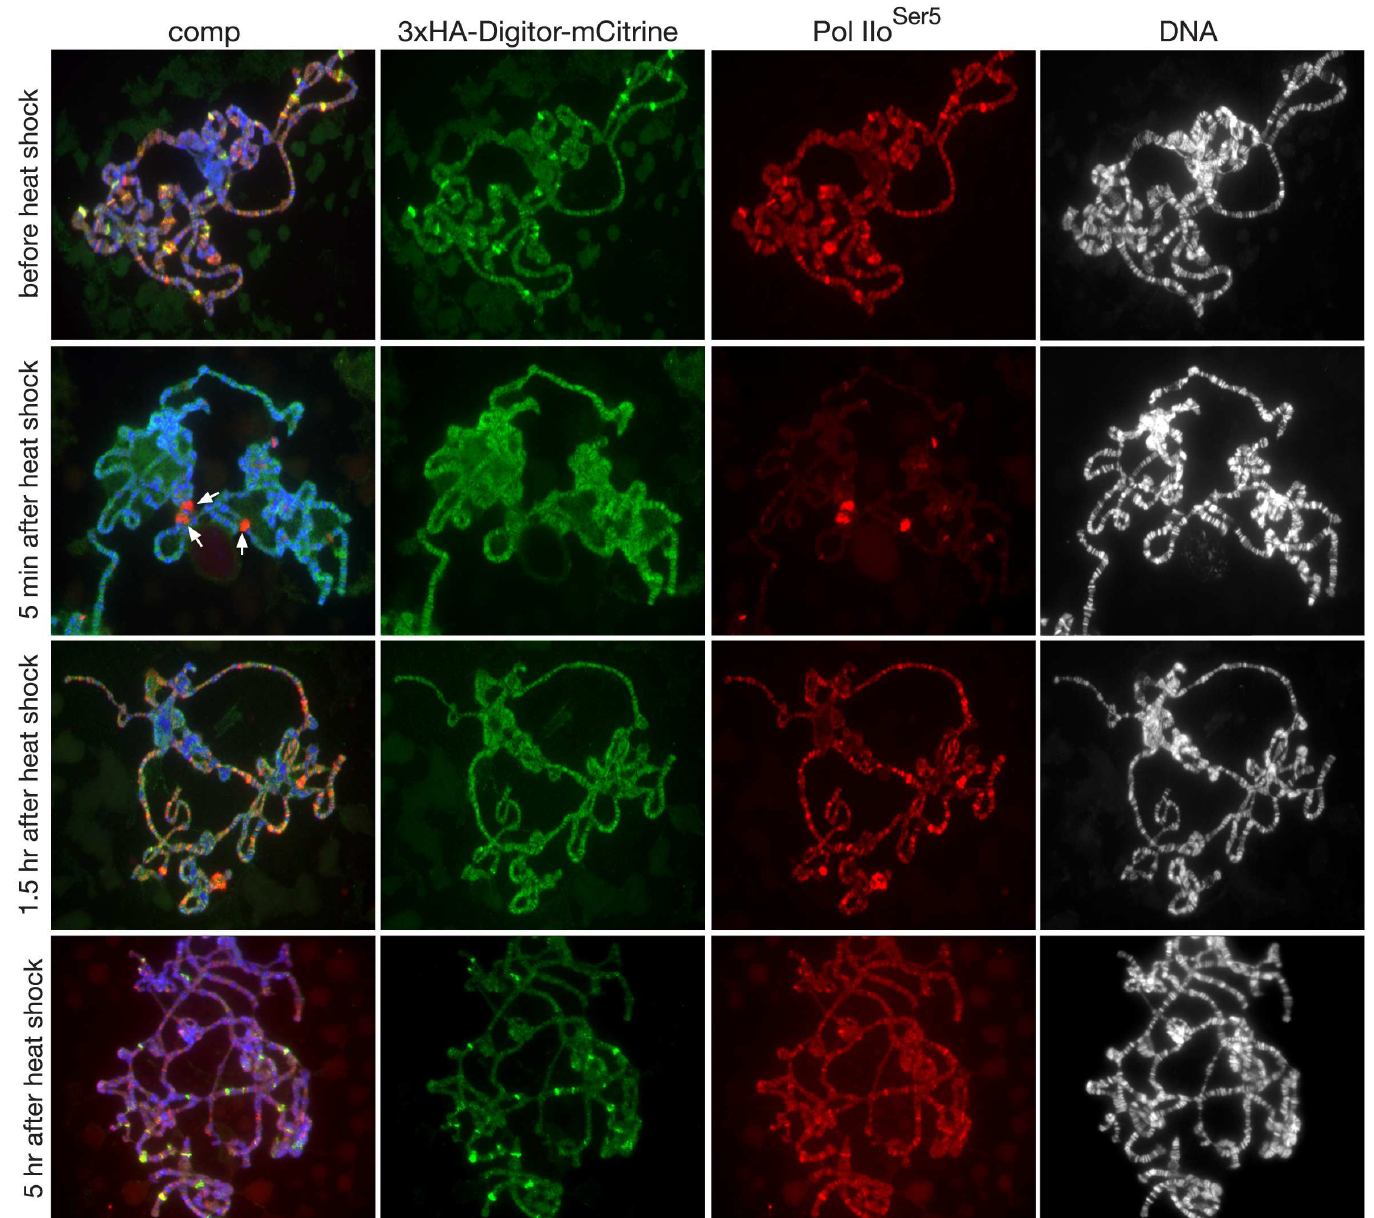
Fig 5. Localization of 3xHA-Digitor-mCitrine before and after heat shock treatment. The figure shows images of polytene squash preparations before heat shock as well as 5 min, 1.5 hr, and 5 hr after heat shock. The preparations were labeledwith anti-HA antibody to detect the 3xHA-Digitor-mCitrine construct (in green), with anti-Pol IIo ser5 antibody (in red), and with Hoechst for DNA (in blue/grey). Arrows indicatePol IIo ser5 -positive heat shock-induced puffs 5 min after treatment.